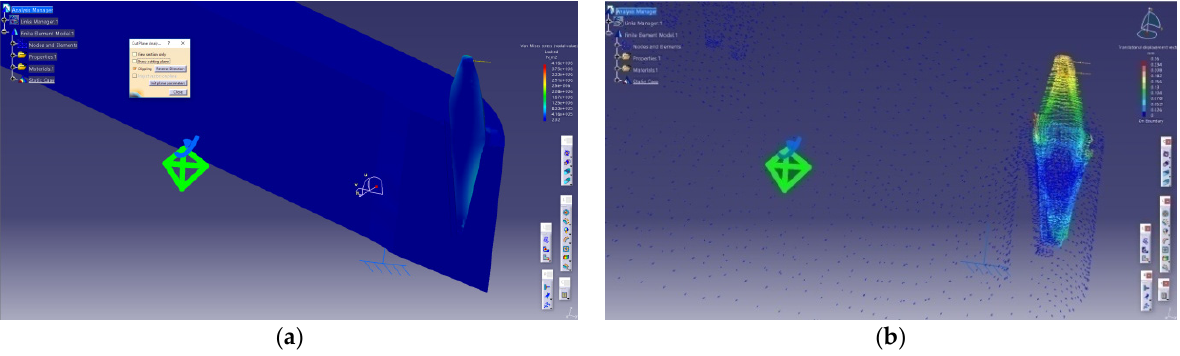
Figure 8. Lingualization of the LLI using a 1 N force: ( a ) von Mises tensions, no HBL; ( b ) tooth movement obtained, no HBL.